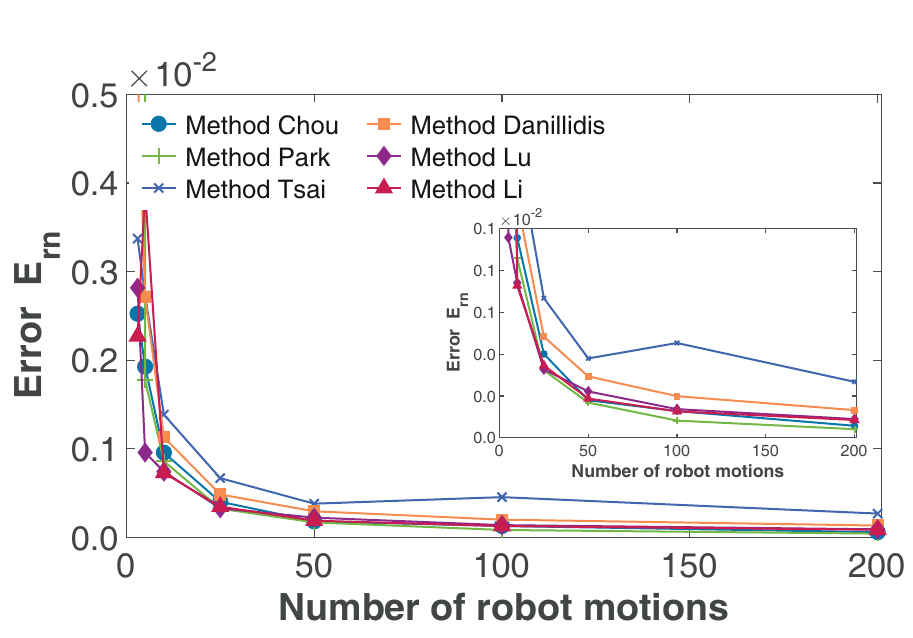
Fig 4. Effect of the number of robot motions on relative transformation error E the zoomed in accuracy level between E rn of 0 and 0.001.